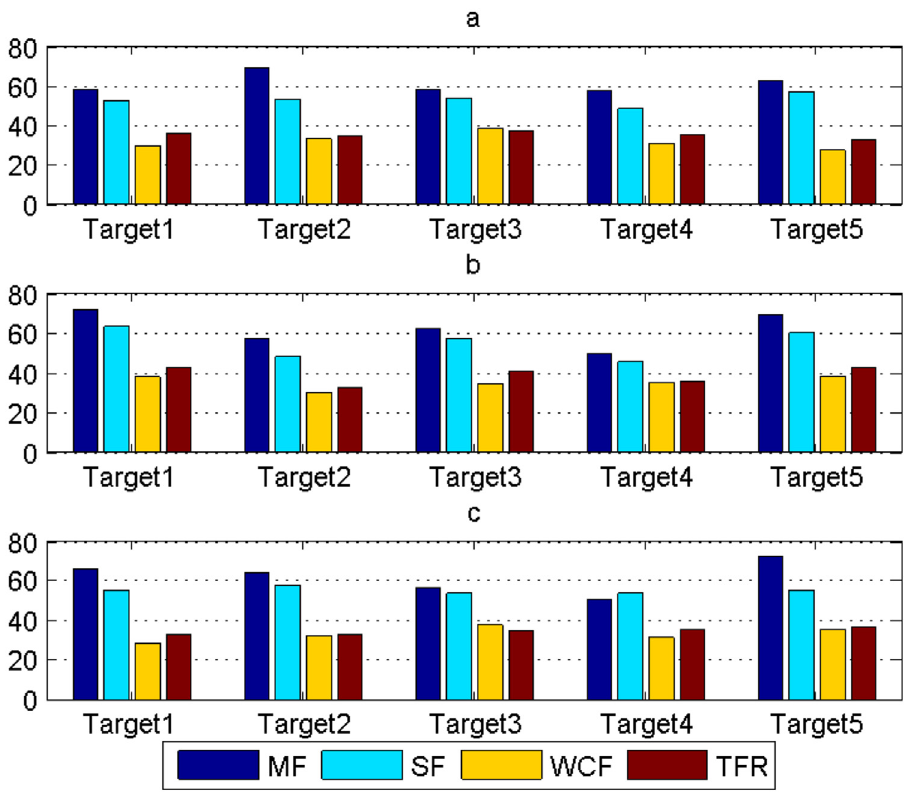
Fig 5. Comparisons of average error among MF, SF, WCF and TFR of 5 targets. (a) In x -axis, (b) In y - axis, and (c) In z -axis.